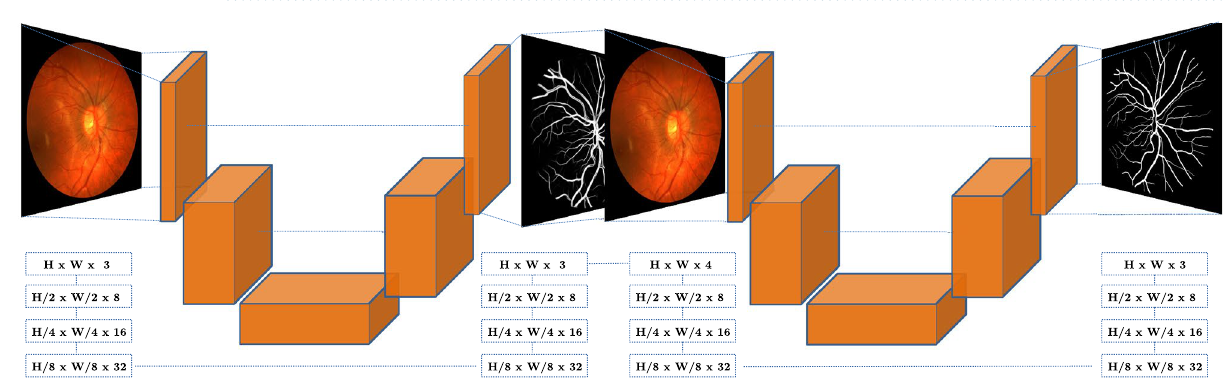
Figure 2. Representation of the WNet architecture. The left-hand-side part of the architecture corresponds to a standard minimal U-Net φ 3,8 with ∼ 34 K parameters, which achieves performance on-par with the state-of- the-art. The full W-Net, defined by Eq. (1), is composed of two consecutive U-Nets; it outperforms all previous approaches with just around 70 k parameters: 1–3 orders of magnitude less than previously proposed